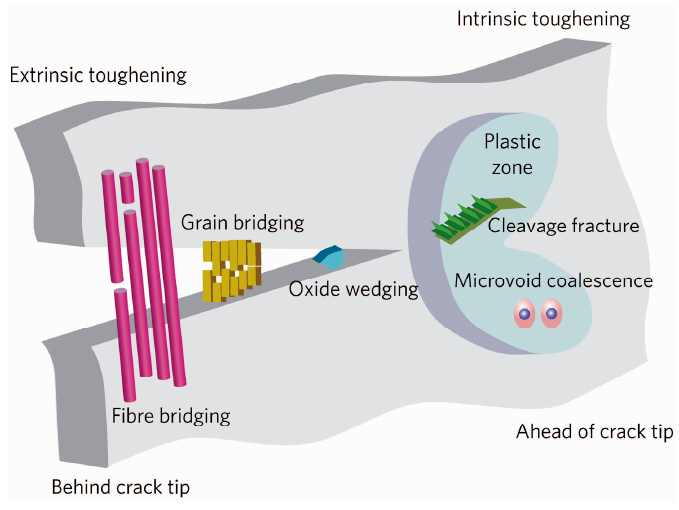
Figure 1. Schematic illustrating both intrinsic and extrinsic mechanisms of toughening mechanisms associated with crack extension